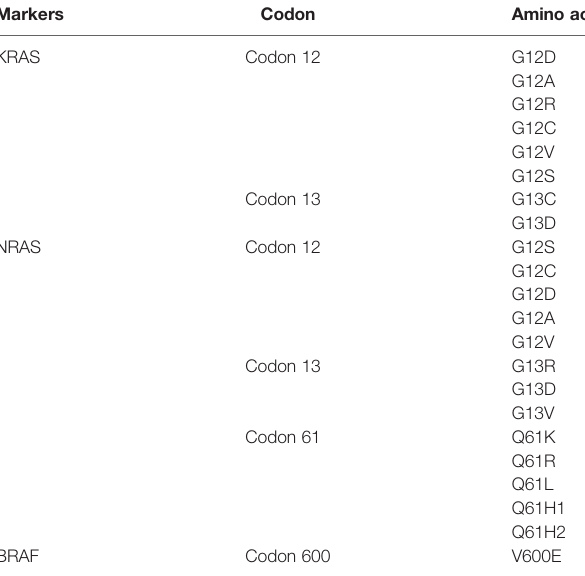
TABLE 1 | Detection of the amino acid (AA) alternations of KRAS, NRAS, and BRAF. Markers